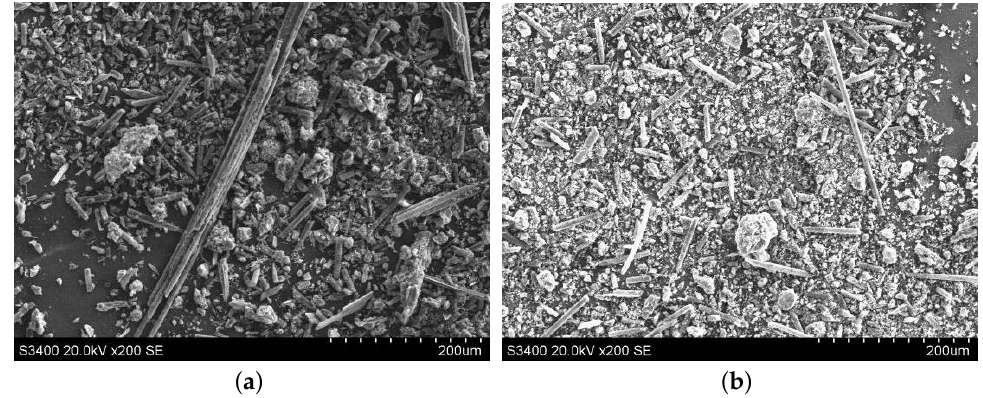
Figure 19. Morphologies comparison when a p is 0.3 mm. ( a ) is ordinary cutting and ( b ) is ultrasound- assisted